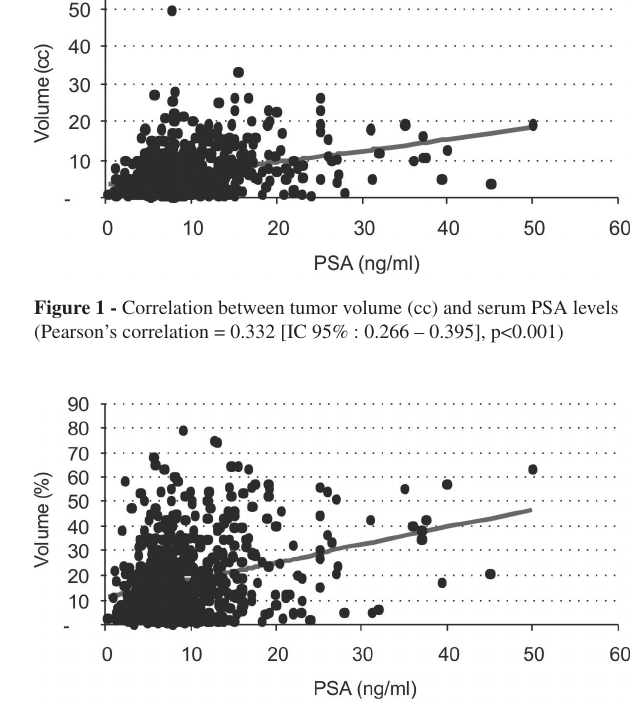
Figure 2 - Correlation between relative tumor volume (%) and serum PSA levels (Pearson’s correlation = 0.289 [IC 95% : 0.221 – 0.354],